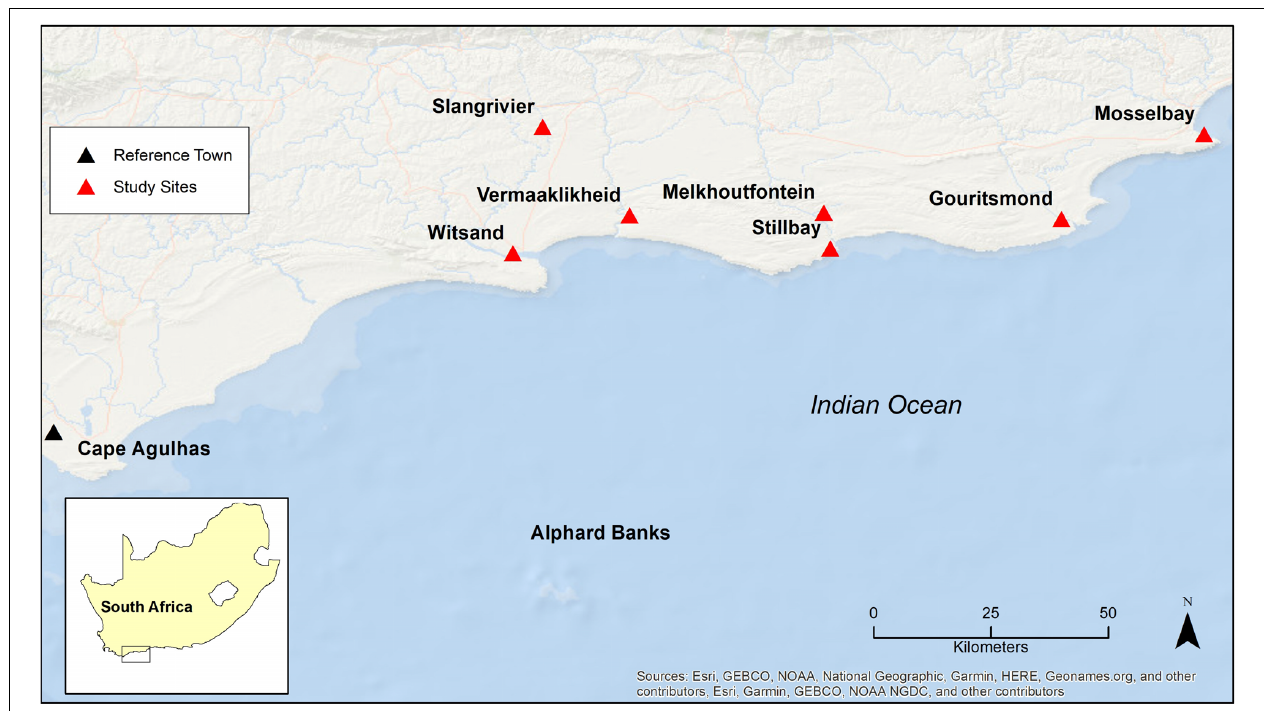
FIGURE 1 | Map of the research area. Mossel Bay is large urban centre situated on the coast; Bitouville is part of Gouritsmond; Melkhoutfontein is situated approximately 8 km from Still Bay on the coast, Vermaaklikheid is 7 km from the coast as the crow flies, but fishers often travel 47 km by road to launch in Still Bay; Slangrivier is situated 26 km inland as the crow flies, fishers travel 38 km by road to